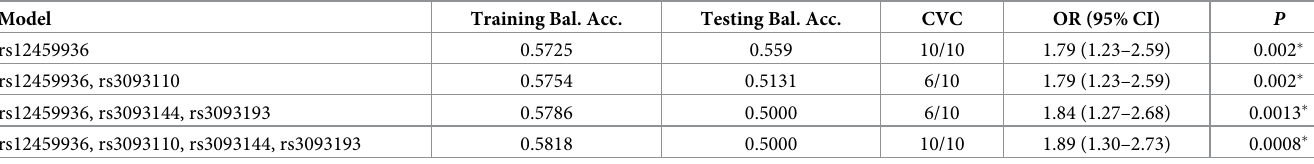
Table 8. MDR analysis for SNP–SNP interaction in CYP4F2 with HAPE risk. Model Training Bal.